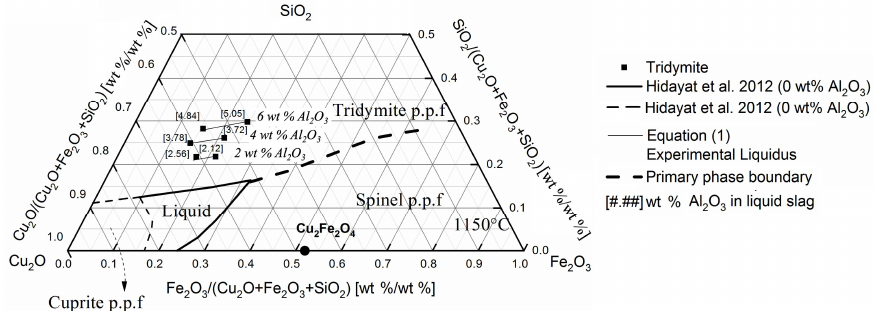
Figure 7. Liquidus for the equilibrium slag/tridymite of the Cu 2 O–Fe 2 O 3 –SiO 2 system with additions of Al 2 O 3 at 1150 °C, in equilibrium with metallic copper.